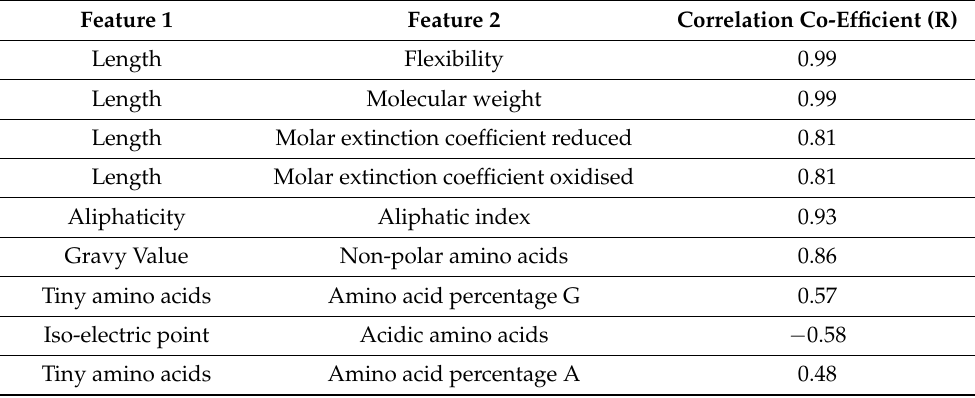
Table 1. Pearson correlation coefficient for protein features with p -value < 0.05.